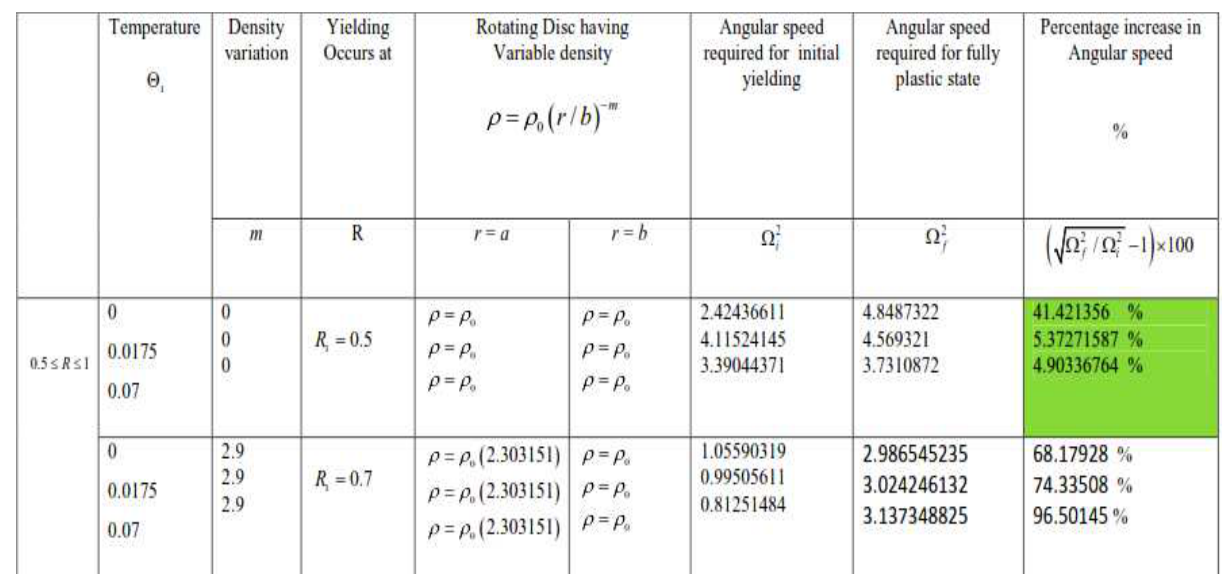
Table 2. Angular speed required for initial yielding 2 of a rotating disc for m =0.00, 2.9 and